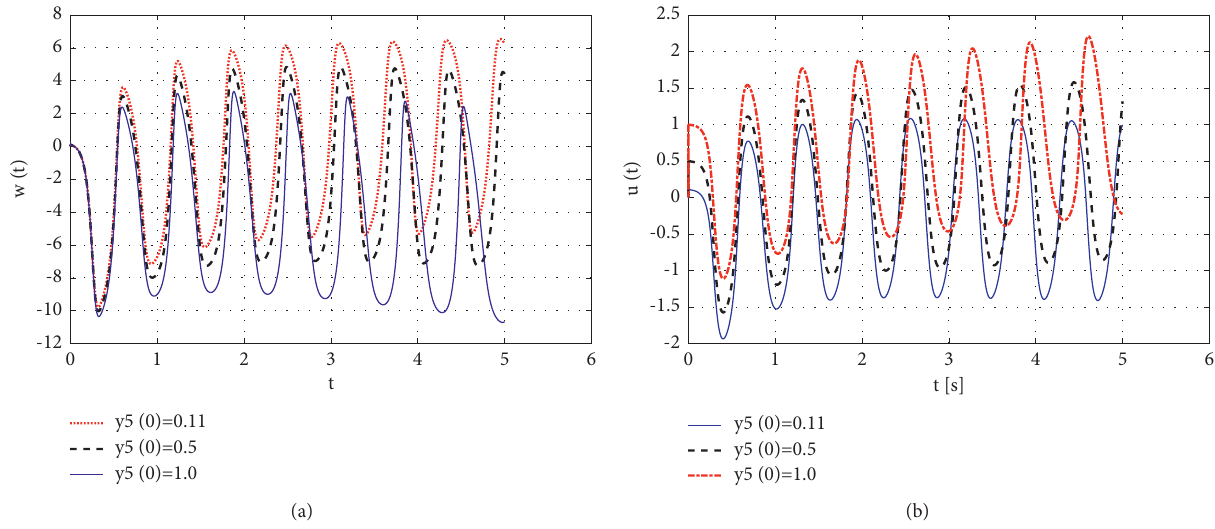
Figure 9: Some of the time series orbits of the system (25) due to small changes in the initial conditions.